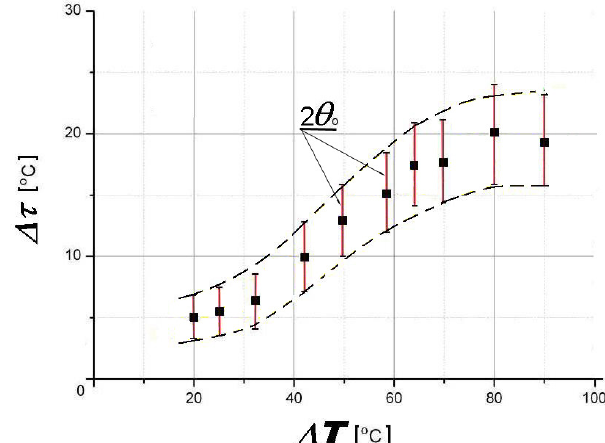
Figure 5. Cooling of the wire, ∆ τ = T 1 − T , during TMO as a function of the initial temperature difference ∆ T ( t = 0 ) = T 1 − T 0 (see Equation (4)). The vertical bars indicate the amplitude of thermo-oscillations, θ 0 , in the stationary state, i.e., after a characteristic time t 0 (cp. with Figure